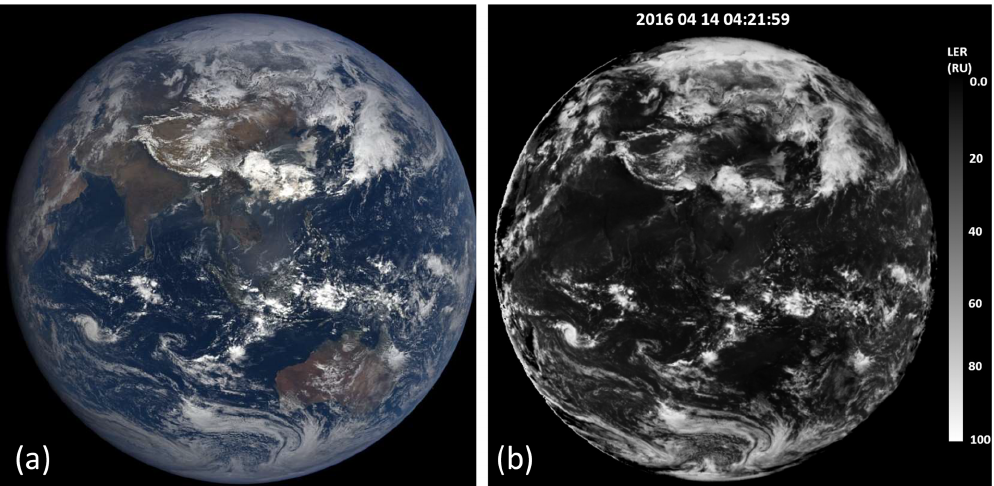
Figure 16. (a) EPIC color image for 14 April 2016 at 04:12:16GMT showing the distribution of cloud cover and land corresponding to Fig. 15. https://epic.gsfc.nasa.gov/ (last access: 16 June 2020). (b) EPIC scene reflectivity LER for 14 April 2016 at